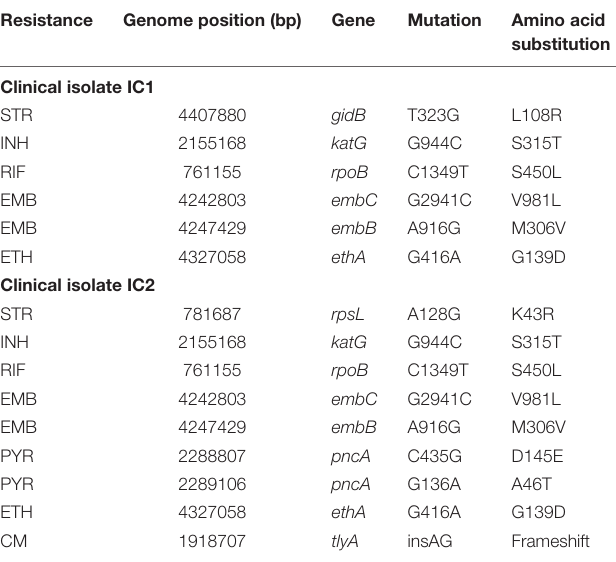
TABLE 1 | Phenotypic and genotypic characteristics of M. tuberculosis IC1 and IC2 clinical isolates. Resistance Genome position (bp) Gene Mutation Amino acid